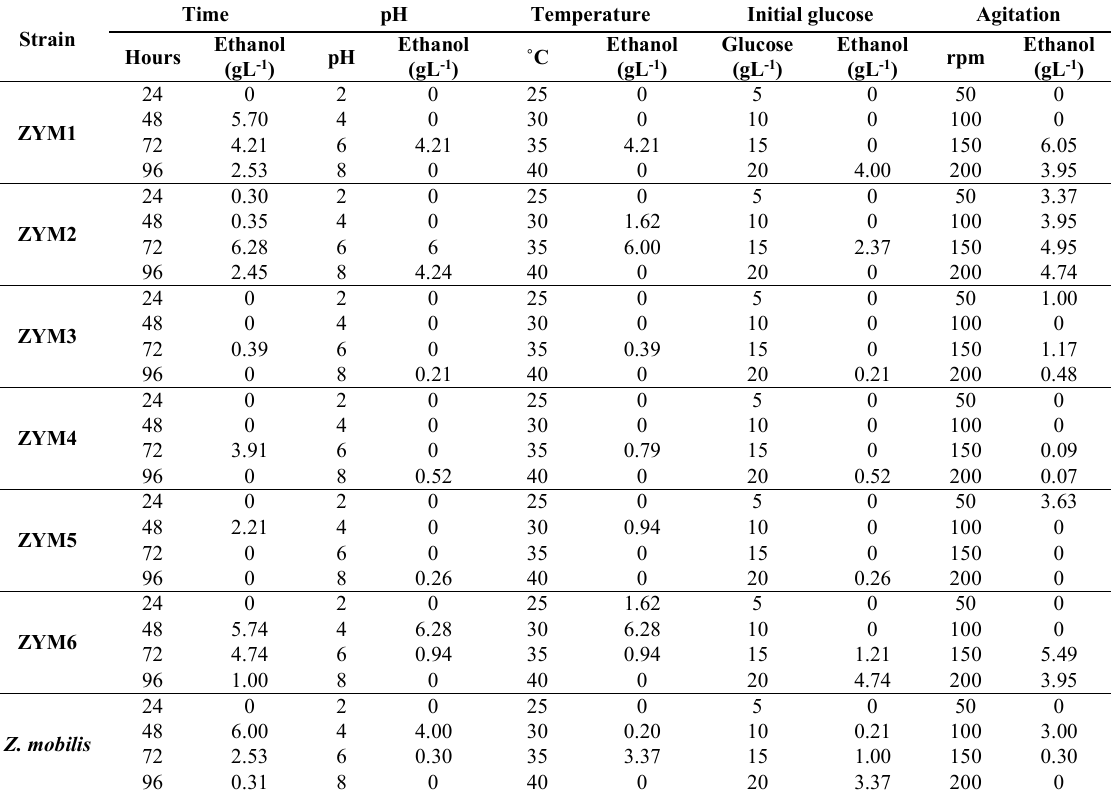
Table 2 Effect of pH, time, initial glucose concentration, temperature and agitation on production of ethanol by isolated